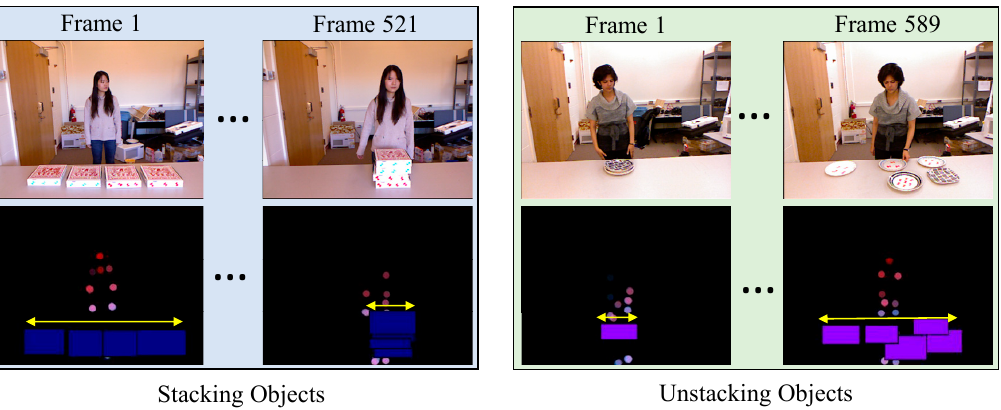
Figure 9. Illustration of spatial features between stacking and unstacking objects (First row: RGB image; Second row: DCNN input image; yellow line indicates total object width). Table 6. Confusion matrix for recognizing interactions in the CAD-120 dataset.